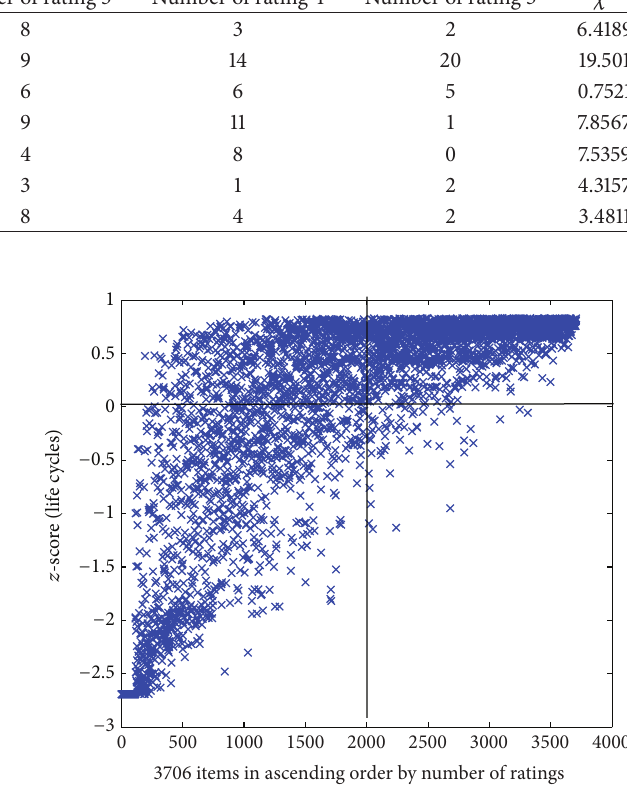
Figure 1: The relationship between the number of ratings and the number of items.